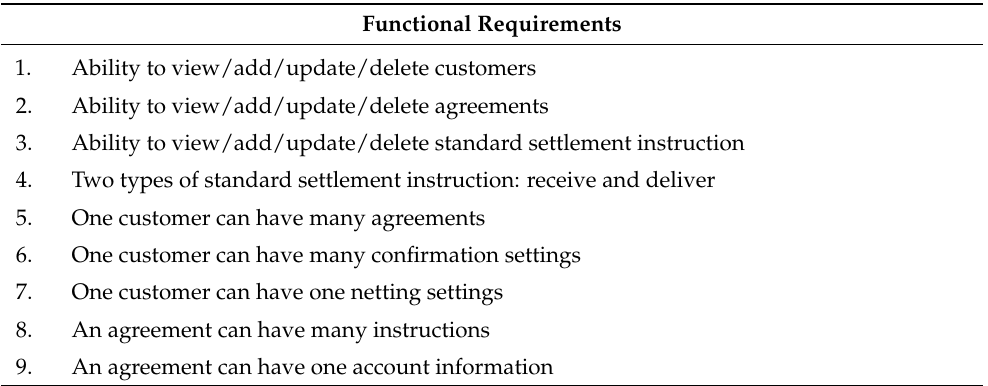
Table 1. The functional requirements of the SSI application.